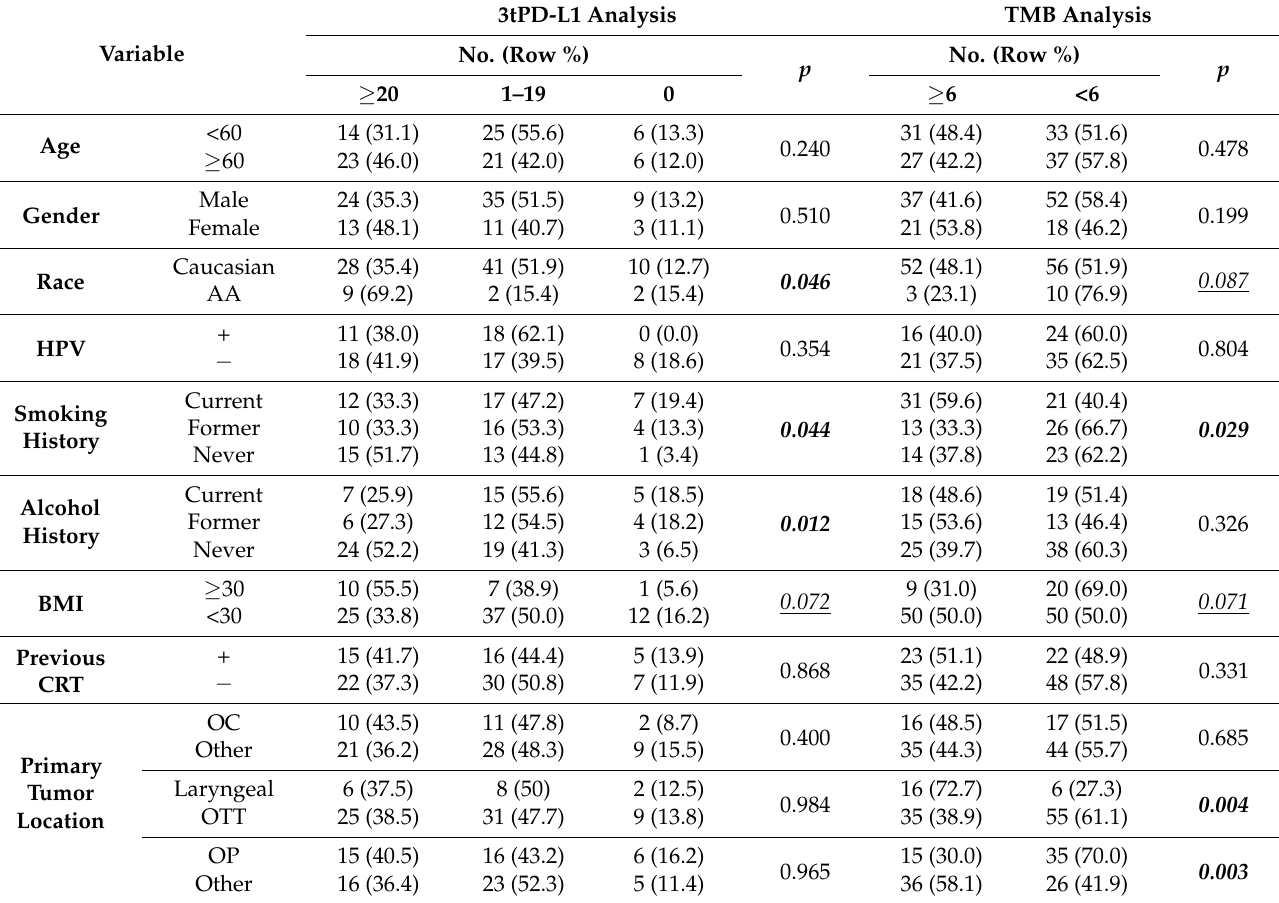
Table 2. Correlation of select demographic and patient specific data with 3-tiered-PD-L1 and 2-tiered TMB